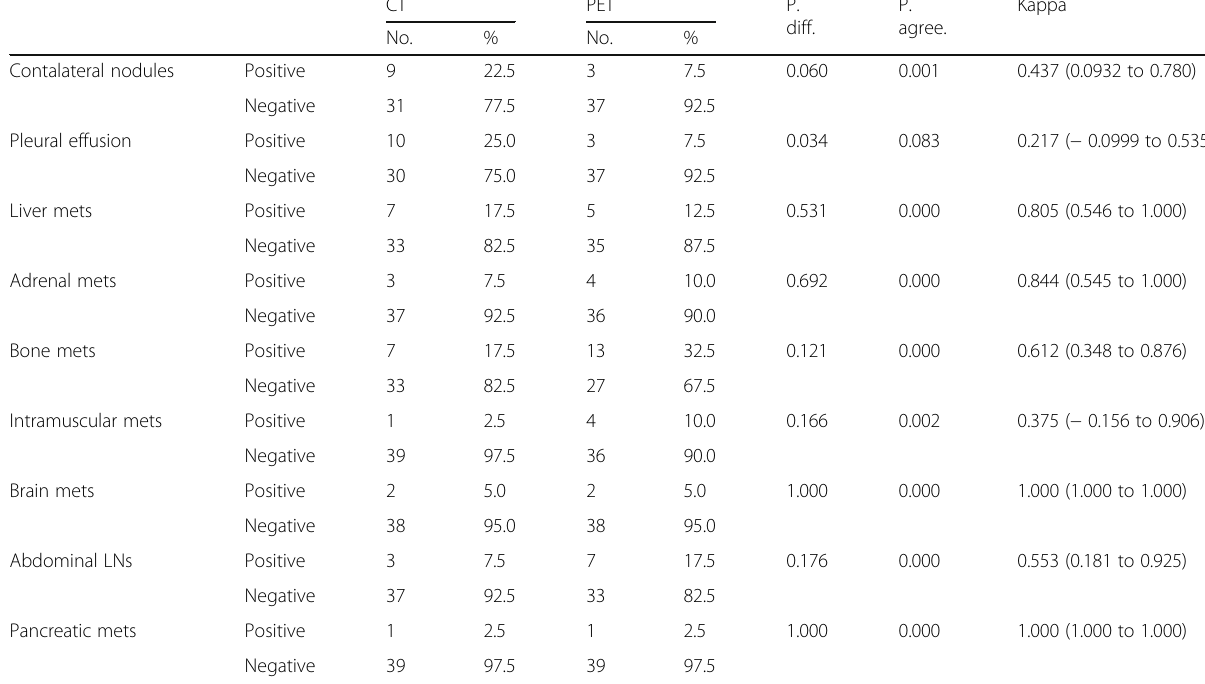
Table 4 Showing the sites of distant metastases by CT versus PET-CT CT PET